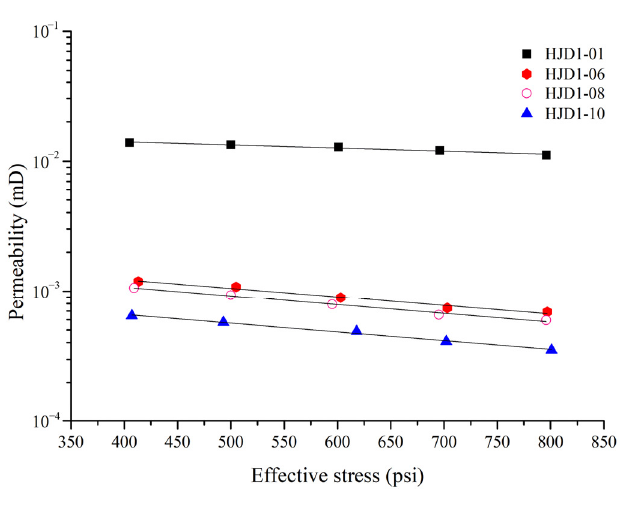
Figure 6. Relationship between the effective stress and permeability. Table 4. Linear fitting results between permeability (y, mD) and effective stress (x, psi).